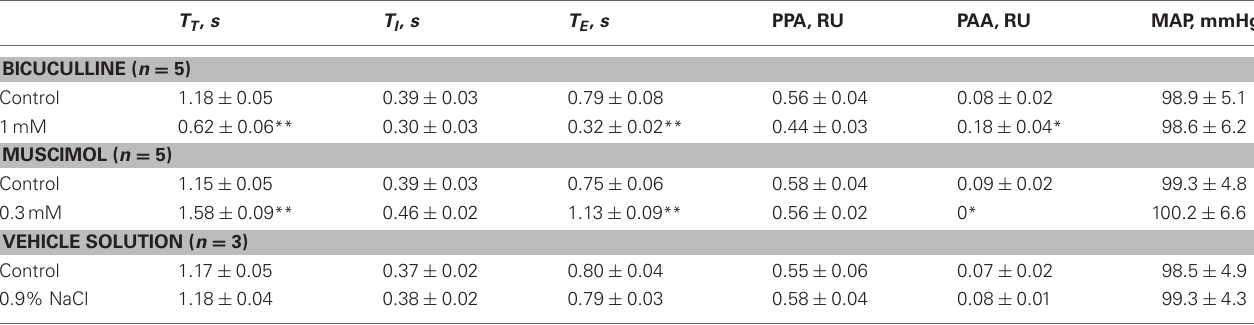
Table 1 | Cardiorespiratory variables during eupneic breathing before and ∼ 10min after bilateral microinjections of 1mM Bicuculline, 0.3mM Muscimol, and vehicle solution into the